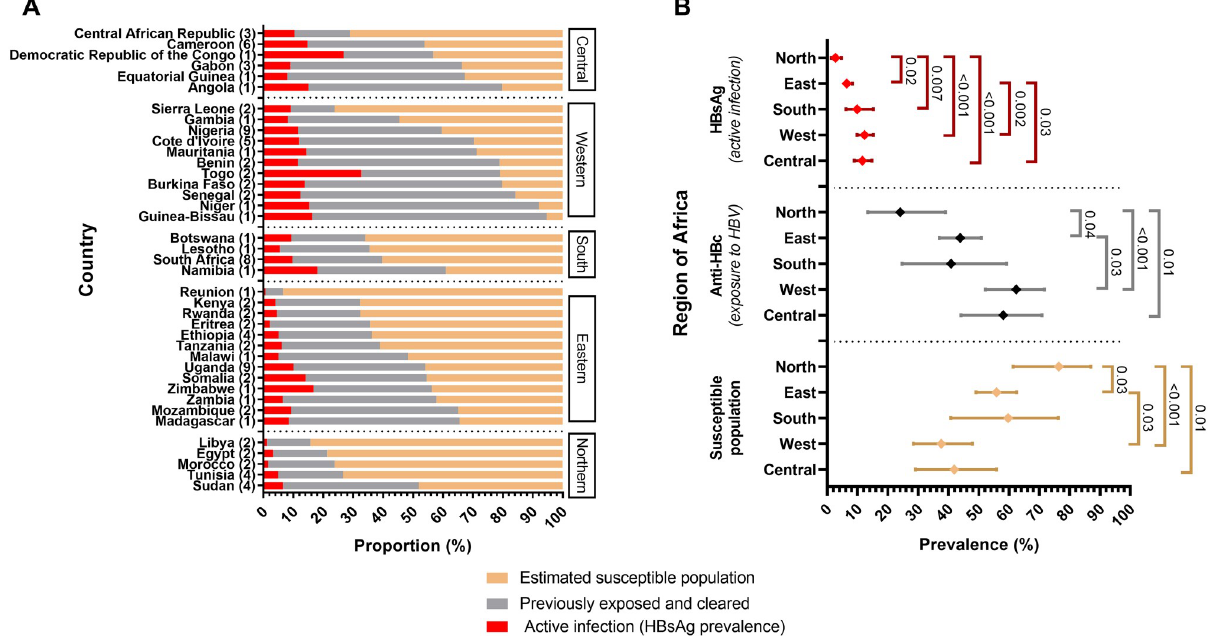
Fig 5. Estimated proportion of the population with chronic HBV infection (HBsAg), total exposure (anti-HBc), and susceptibility to HBV infection, divided by (A) country and (B) region of Africa. Countries have been grouped by region according to the UN geoscheme for Africa [24]. The number of studies per country is given in brackets next to the country name. Two studies were counted twice as they contained cohorts from 2 different countries. Per-country estimations were calculated, weighting individual studies according to cohort size. In panel (B), boxplots show the weighted estimations of prevalence with 95% confidence intervals, with significant differences indicated. See methods for definitions of infection, previous exposure, and susceptibility. Anti-HBc, antibody to hepatitis B core antigen; HBsAg, hepatitis B surface antigen; HBV, hepatitis B virus; UN, United